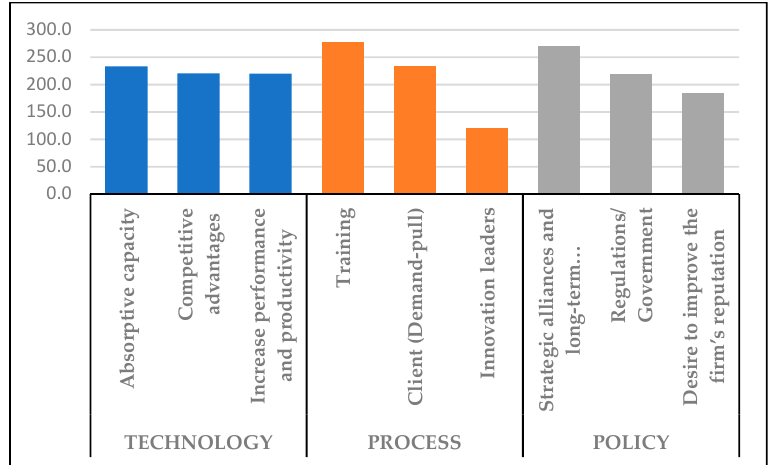
Figure 4. Top three BIM innovation drivers in developing countries. Table 8. Scores and ranks of BIM innovation drivers in developing countries.